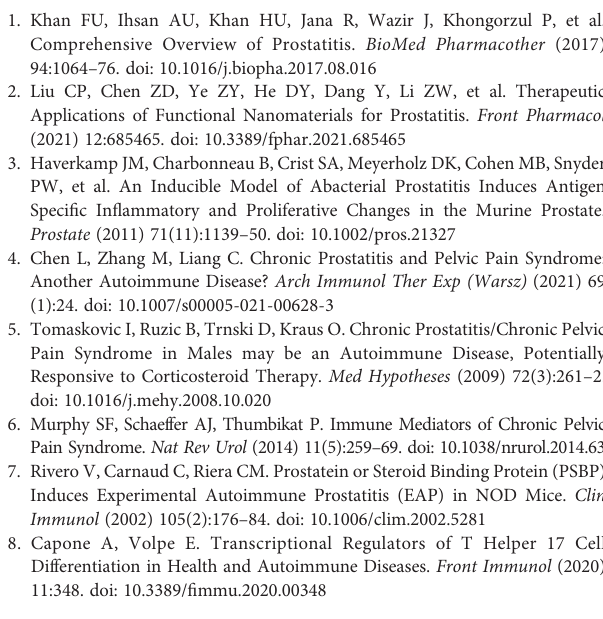
Supplementary Figure 1 | The relative mRNA expressions of transcription factor T-bet and GATA3 in the splenic lymphocytes from control and EAP mice. (A) The relative mRNA expression of transcription factor T-bet in the splenic lymphocytes fromcontrolandEAPmice. (B) TherelativemRNAexpression oftranscriptionfactor GATA3 in the splenic lymphocytes from control and EAP mice. Data are the representative of three independent experiments. n=3/group; *, P <0.05; NS, not signi fi cant; EAP, experimental autoimmune prostatitis; T-bet, T-box expressed in T cells; GATA3, GATA binding protein 3. Supplementary Figure 2 | Comparison of gut microbiome between control and EAP mice. (A) A Venn diagram of OTUs in EAP and control mice. (B) a -diversity indices (observed_species, and PD_whole_tree) of bacterial 16S rRNA gene of fecal samplesfromcontrolandEAPmice. (C) Relativeabundanceofgutmicro fl oraatclass, order, family, and species levels from control and EAP mice. n=10/group; **, P <0.01; EAP, experimental autoimmune prostatitis; OTUs, operational taxonomic units. Supplementary Figure 3 | PICRUSt analysis revealed that the metabolic pathways of butanoate metabolism and propanoate metabolism (highlighted in red boxes) might be relevant to EAP. n=10/group; EAP, experimental autoimmune prostatitis; PICRUSt, phylogenetic investigation of communities by reconstruction of unobserved states. Supplementary Figure 4 | Detection of the absolute concentrations of SCFAs, including pentanoic acid, isobutyric acid, and isovaleric acid, in control and EAP mice (A) The absolute concentrations of SCFAs, including pentanoic acid, isobutyric acid, and isovaleric acid, in feces from control and EAP mice. (B) The absolute concentrations of pentanoic acid, isobutyric acid, and isovaleric acid in serum from control and EAP mice. Data are the representative of three independent experiments. n=6-10/group; NS, not signi fi cant; EAP, experimental autoimmune prostatitis; SCFAs, short-chain fatty acids. Supplementary Figure 5 | Analysis of the GPR43 protein expression levels and the relative mRNA expressions of HDAC6 in different groups. (A) Immunoblot analysisofGPR43expressionlevelsinTregcellsthatwereisolatedfrommiceoffour groups: EAP group, EAP+PA group, EAP+PA+sh Control group, and EAP+PA+sh GPR43 group. (B) The relative mRNA expressions of HDAC6 in Treg cells that were isolated from mice of the four groups. n=3/group; *, P <0.05; NS, not signi fi cant; EAP, experimental autoimmune prostatitis; PA, propionic acid; GPR43, G-protein coupled receptors 43; HDAC6, histone deacetylase 6; Treg, regulatory T